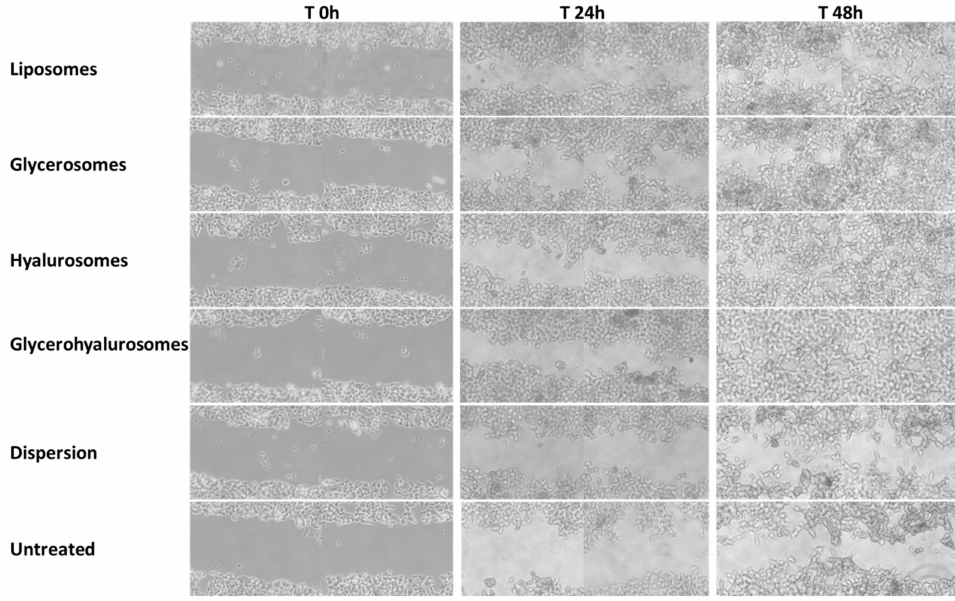
Figure 6. Representative images of wound closure in a monolayer of fibroblasts untreated or treated with canthaxanthin in dispersion or loaded in vesicles at 0 h, 24 h, and 48 h.